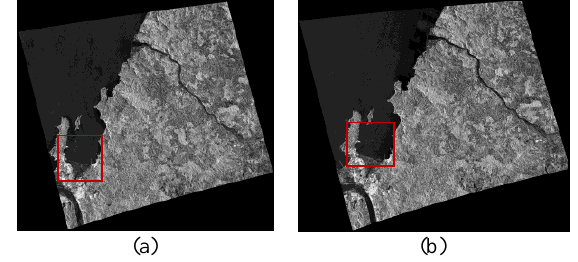
Figure 4. ALOS/PALSAR raw images: (a) Image before the disaster (2009/3/11) and (b) Image after the disaster (2010/3/14)